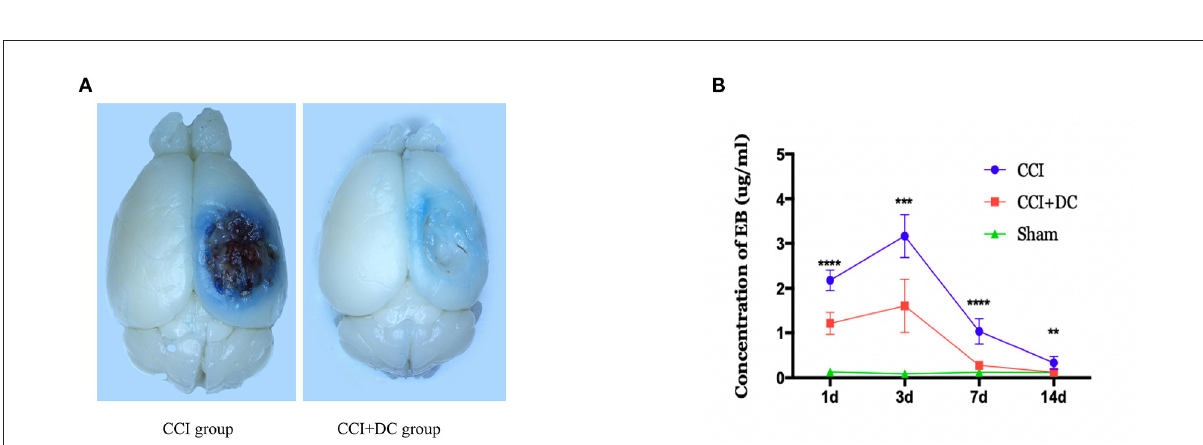
FIGURE5 Effects on the blood-brain barrier. (A) General view of brain tissue after EB tail injection in rmice on 3 days after traumatic brain injury. (B) EB was extracted from the brain tissue to calculate the infiltration content of EB, and the results indicated that the infiltration amount of EB in the CCI + DC group was significantly reduced compared with the CCI group at each time point after CCI, with significant statistical difference ( n = 6/group, ** P < 0.01, *** P < 0.001, **** P < 0.0001 vs. CCI